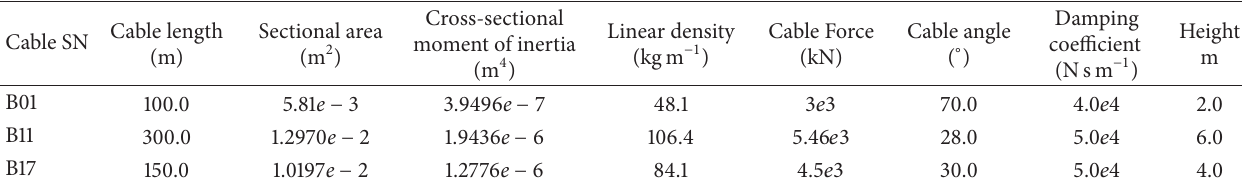
Figure 6: Flowchart of cable FEM model updating driven by PSO method. Table 2: Simulation parameters for cables.